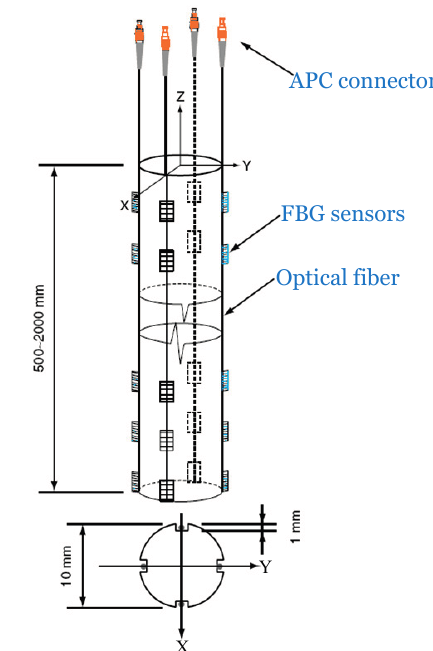
Figure 3. A Design of the FBG sensing bar for 3-D displacement